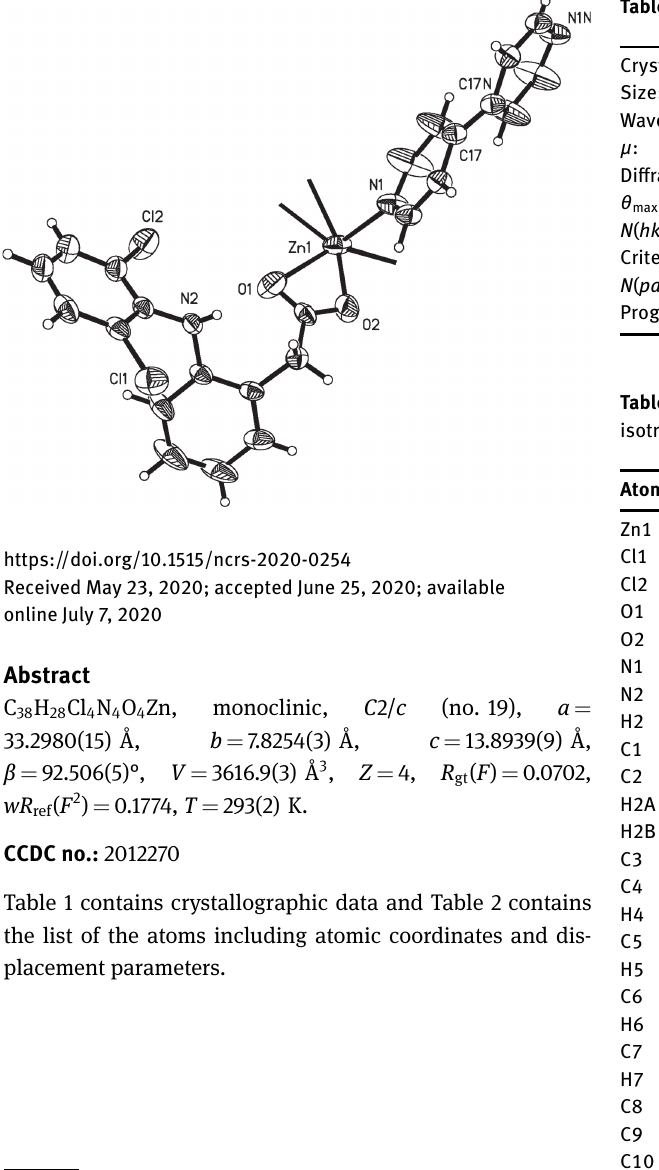
Table 1 contains crystallographic data and Table 2 contains the list of the atoms including atomic coordinates and dis- placement parameters.